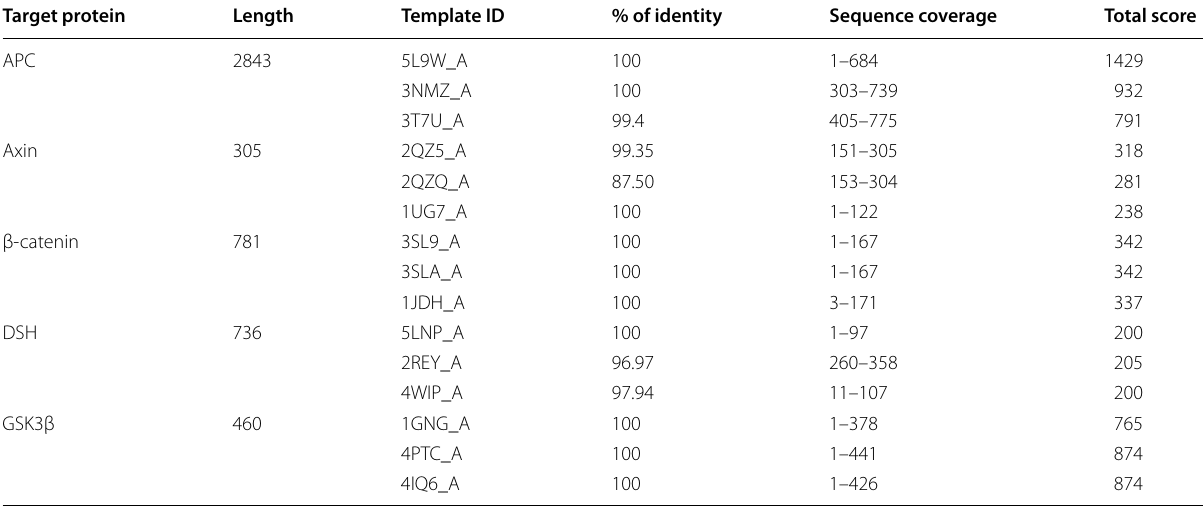
Table 4 WNT signalling proteins and template structures predicted using Swiss